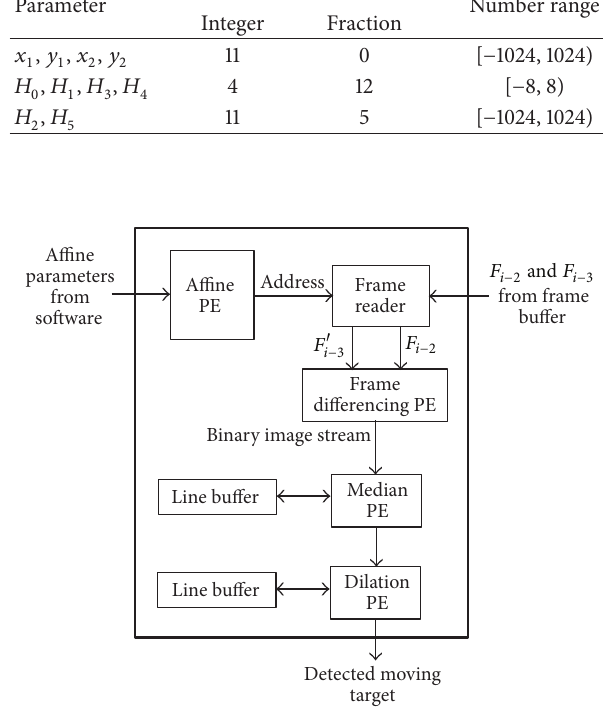
Figure 8: Hardware datapath of fitness scoring in RANSAC accel- erator.